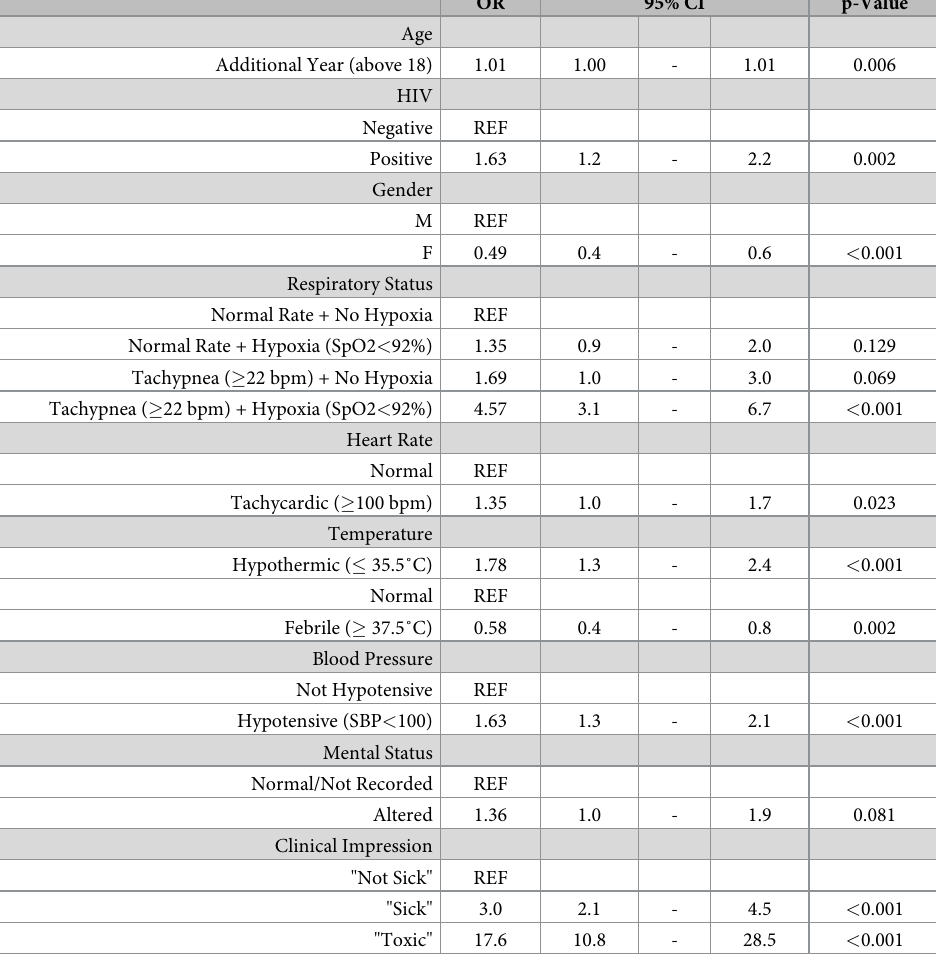
Table 3. Logistic regression model of mortality in septic (qSOFA � 1) patients without malaria: 2012–2019 (N = 5,323).